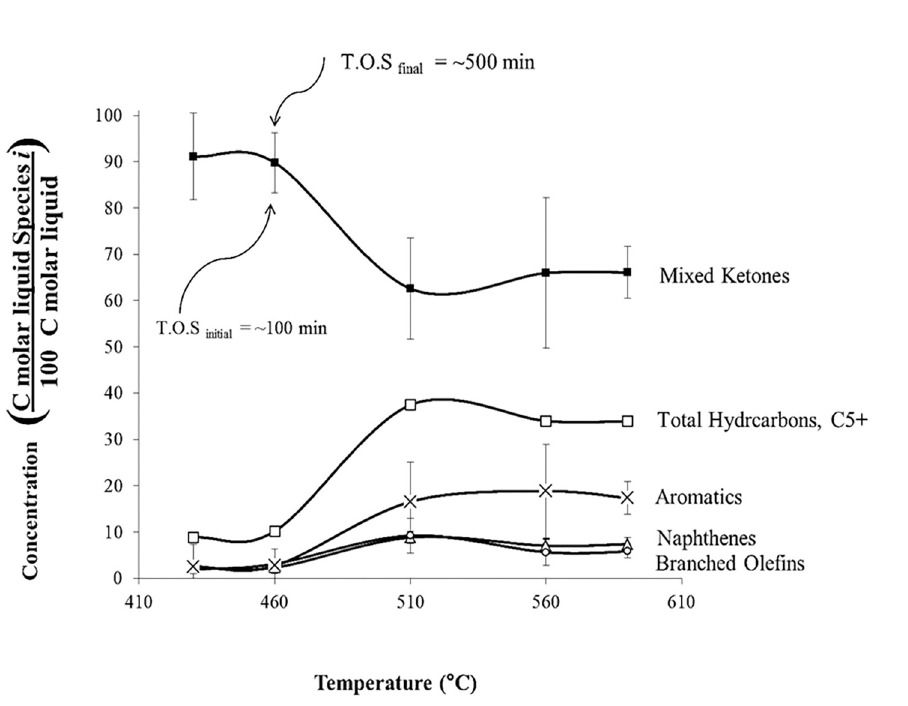
Fig 14. Liquid product distribution for mixed-ketone reaction over HZSM-5(280), WHSV = 1.9 h –1 , and P = 101 kPa (abs). (Error bars are ± 1 σ ).